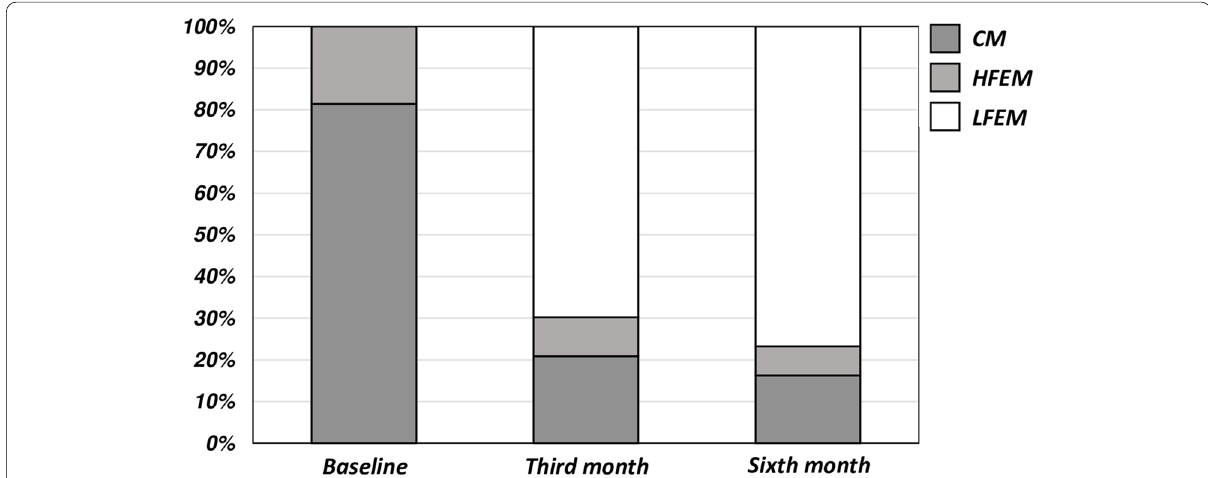
Fig. 5 Percentage of patients with chronic migraine, high frequency episodic migraine and low frequency episodic migraine at baseline (T 0 ), and at the end of the third (T 1 ) and of the sixth month (T 2 ) of galcanezumab administrations